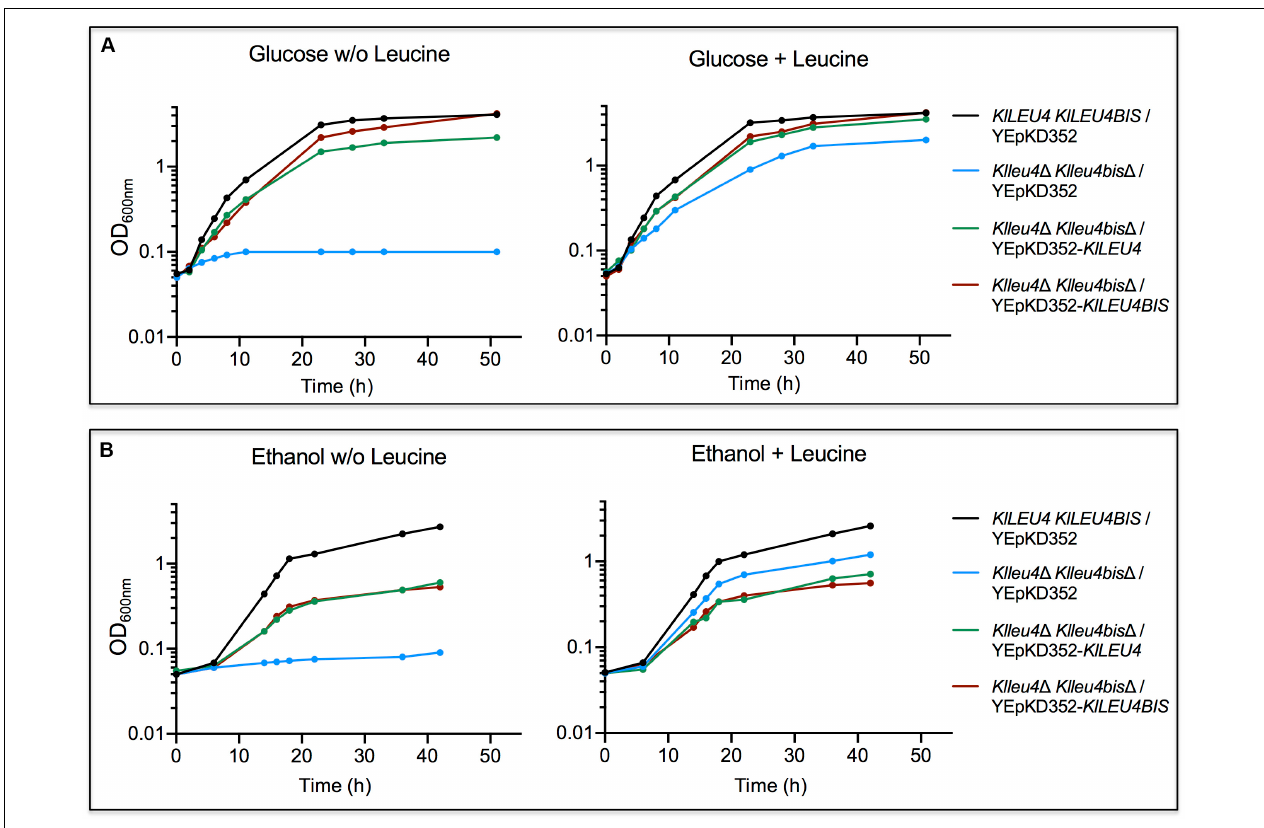
FIGURE 3 | K. lactis growth curves of double Klleu4 (cid:49) Klleu4bis (cid:49) mutant transformed with KlLEU4 or KlLEU4BIS . Strains were grown on minimal medium with either 2% w/v glucose (A) or 2% v/v ethanol (B) as carbon sources, with or w/o leucine (0.1 mg/mL). Growth curves of wild type KlLEU4 KlLEU4BIS harboring YEpKD352 are shown as growth controls. Experiments were done in